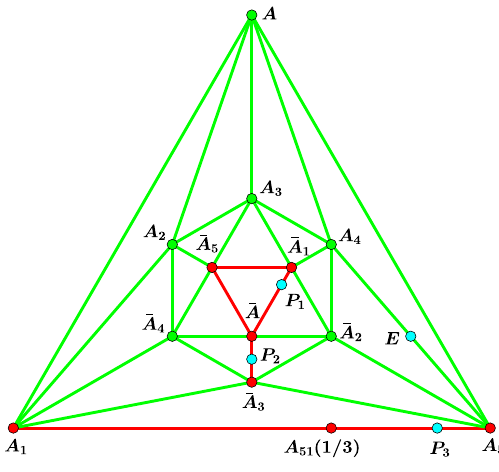
Figure 5. Points P 1 = H ( E ) , P 2 = G ( E ) , P 3 = F ( E )